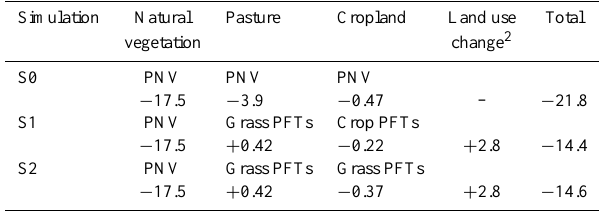
Table 5. Cumulative NECB (PgC) 1901–2006 for the African con- tinent in the different land covers in the various simulations 1